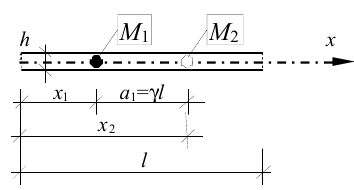
Figure 2. Fragment of periodic beam with a periodically distributed system of two concentrated masses, M 1 and M 2 .